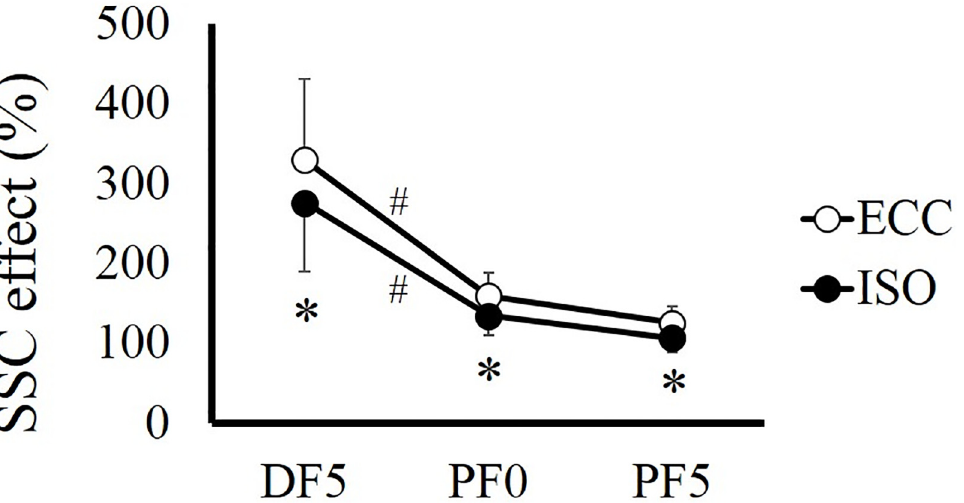
Fig 5. SSC effect calculated at DF5°, PF0°, and PF5° in ECC and ISO conditions. # indicates a significant difference among joint angles in each contraction condition ( P < 0.05). * indicates a significant difference between ECC and ISO at each joint angle ( P < 0.05). CON; concentric contraction without preliminary contraction, ECC; concentric contraction after preliminary eccentric contraction, ISO; concentric contraction after preliminary isometric contraction, DF; dorsiflexion, PF; plantarflexion.